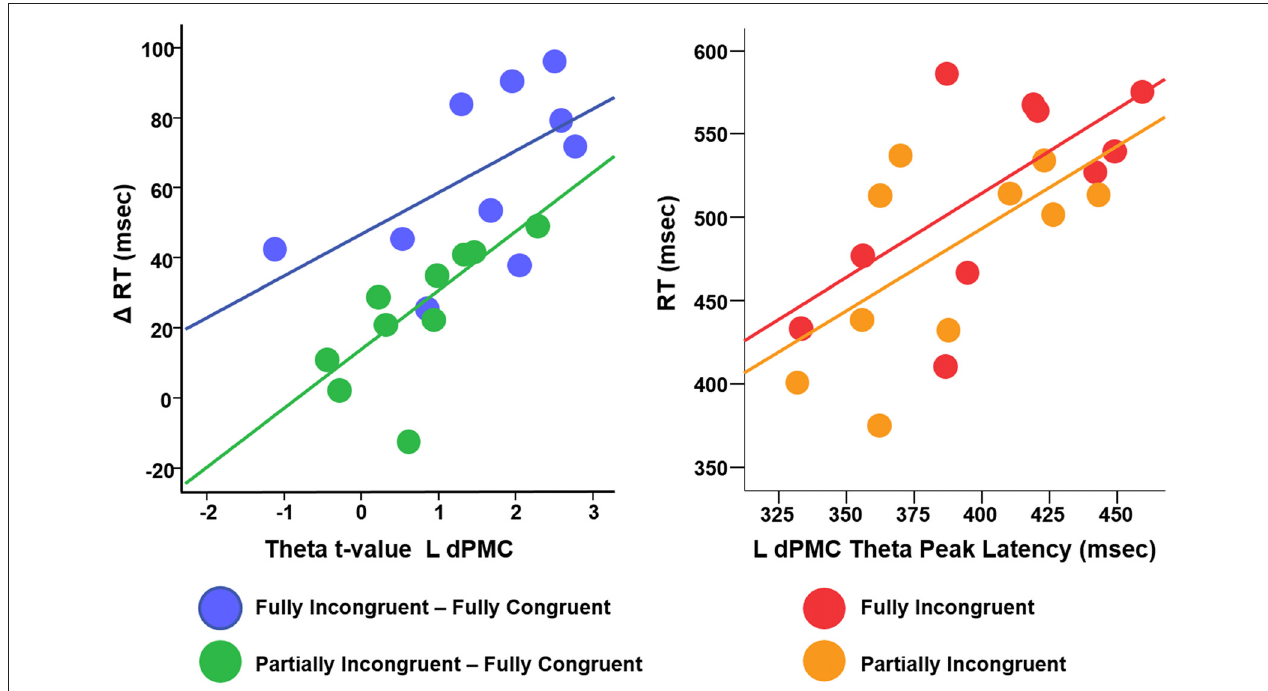
FIGURE 5 | Relationship between difference RT cost ( ∆ RT) and theta t -values (left panel) and between RT and theta peak latency (right